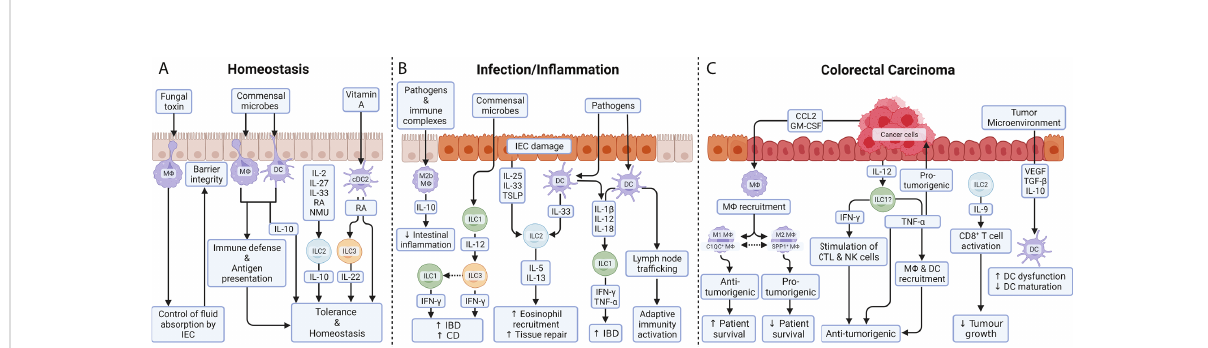
FIGURE 2 Myeloid and innate lymphoid cell function in the colon. (A) During homeostasis, balloon-like protrusions formed by LP-M Ф s sense and limit absorption of fungal toxins by IECs and thus control epithelial integrity. As a large proportion of the luminal microbes are commensals, M Ф s and DCs must be tolerogenic to prevent in fl ammation in homeostatic conditions. Their production of IL-10 ensures low responsiveness to stimulation through TLR and balances T cell activity during homeostasis. Under steady-state conditions, a small proportion of intestinal ILC2s also express the anti-in fl ammatory cytokine IL-10 upon exposure to a variety of exogenous stimuli including IL-2, IL-4, IL-27, IL-10 or neuromedin U (NMU). While the role of ILC2-derived IL-10 remains unclear, it could help to maintain the intestinal mucosa in an